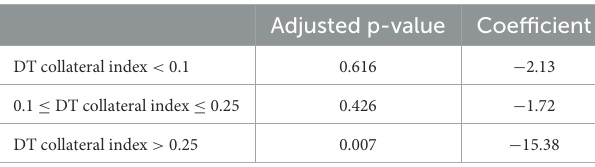
TABLE 3 Predicting core growth rate by IVT across DT collateral index.